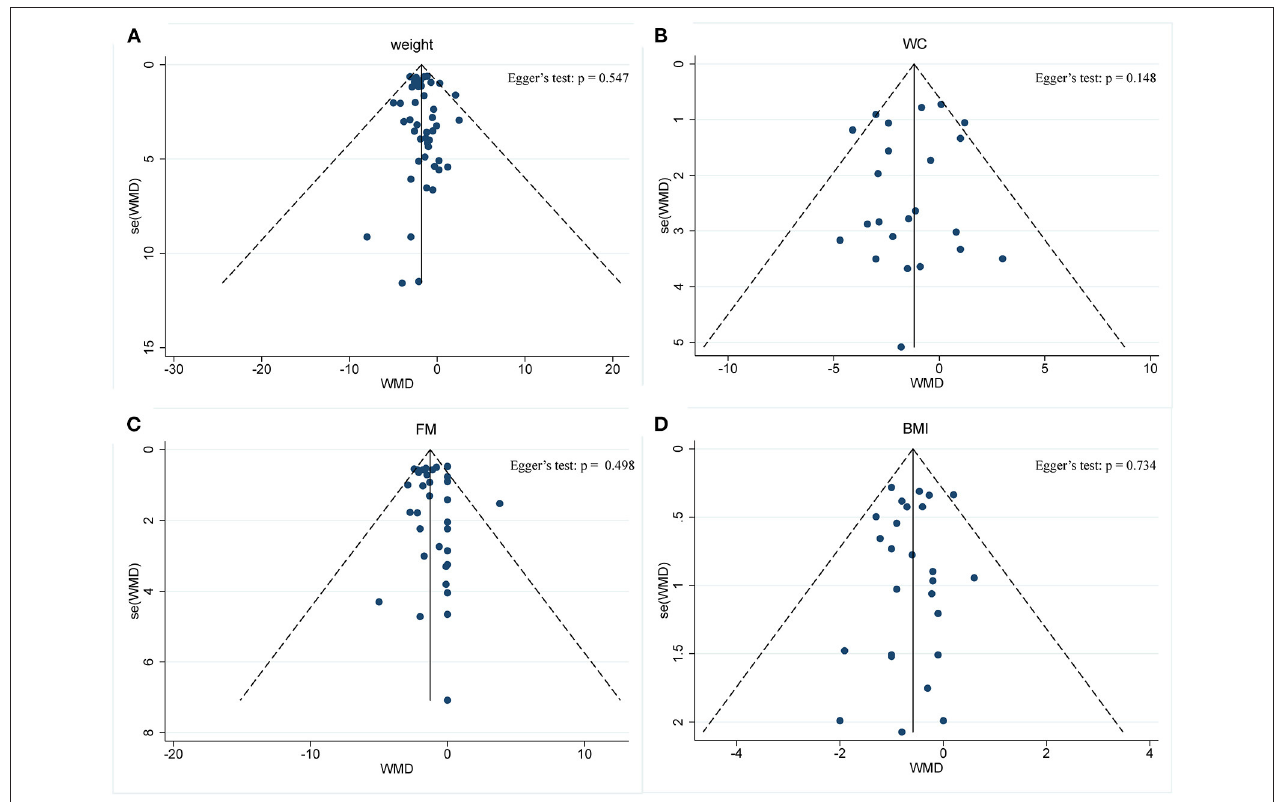
FIGURE 4 | Funnel plot displaying no publication bias in the studies reporting the impact of intermittent fasting on body composition (A) Weight, (B) WC, (C) FM, (D)